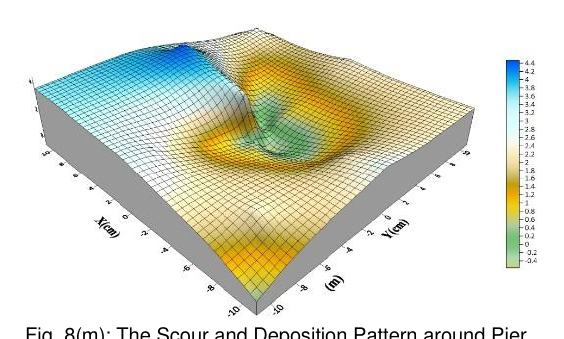
Fig. 8(m): The Scour and Deposition Pattern around Pier (P 2 ) at angle 19 0 and flowrate 9L/Sec.